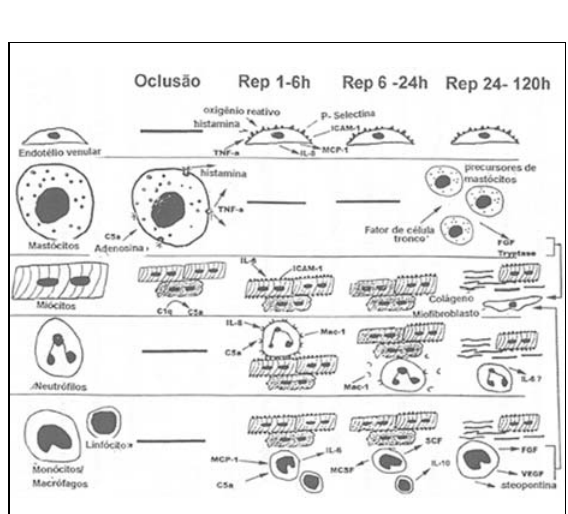
Fig 1- Esquema simplificado dos mecanismos de adesão celular mediado por interleucinas (modificado a partir de Frangogiannis et al. 15